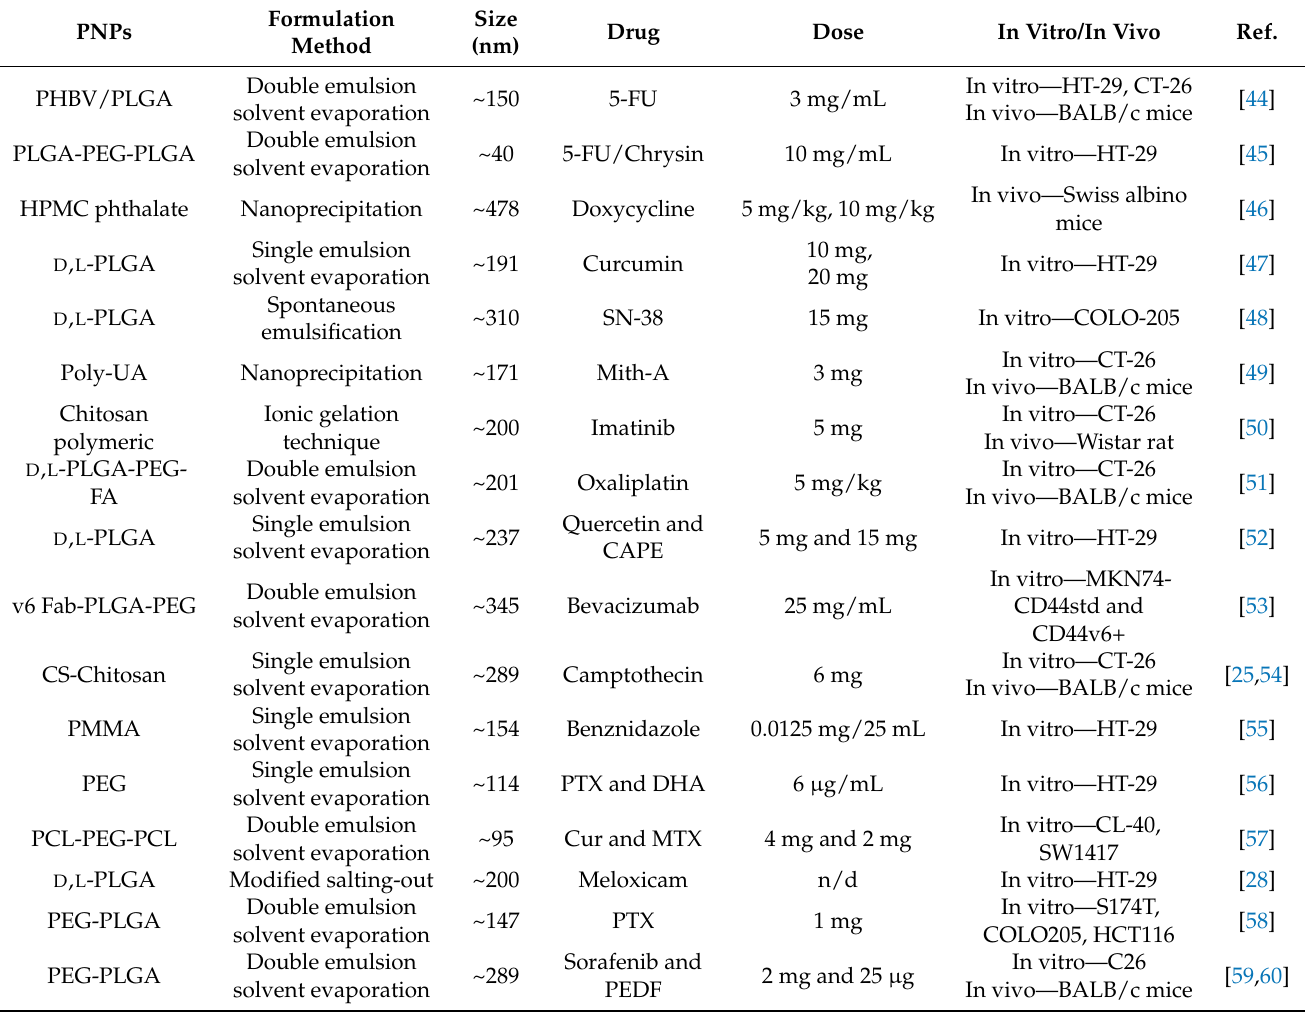
Table 3. Polymeric nanoparticles as drug delivery systems for colorectal cancer